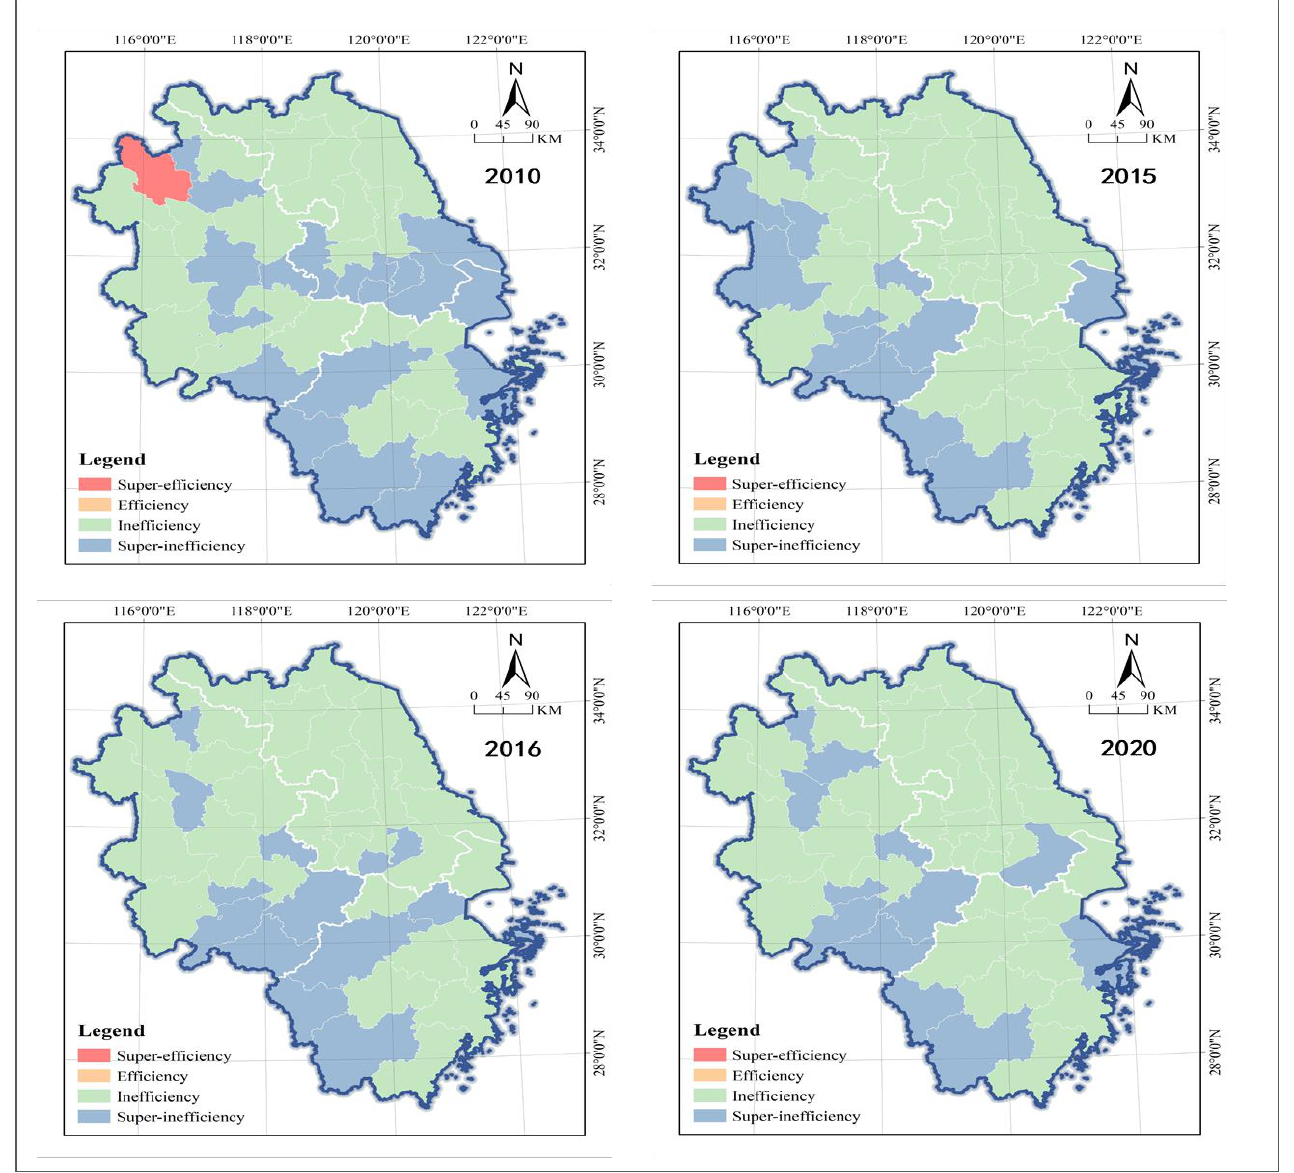
Figure 11. Analysis on the scale efficiency of real estate inventory in Yangtze River Delta.